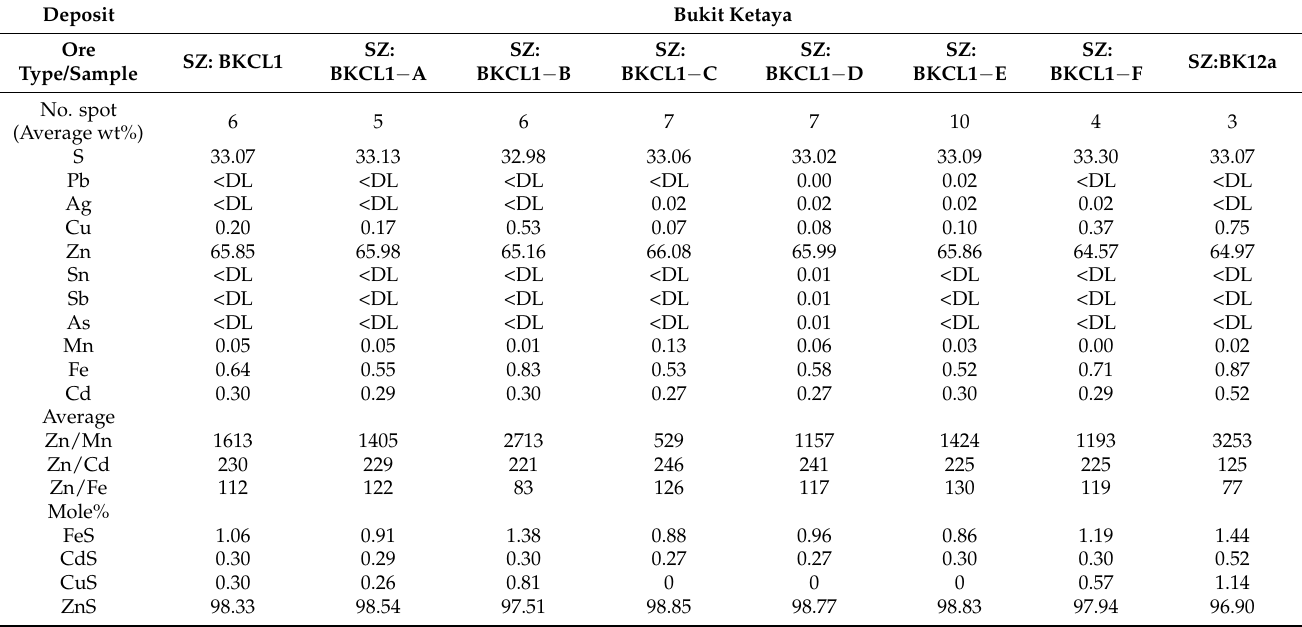
Table 4. Average chemical compositions of the representative sphalerite in the stringer zone from the Bukit Ketaya deposit, Central Peninsular Malaysia.